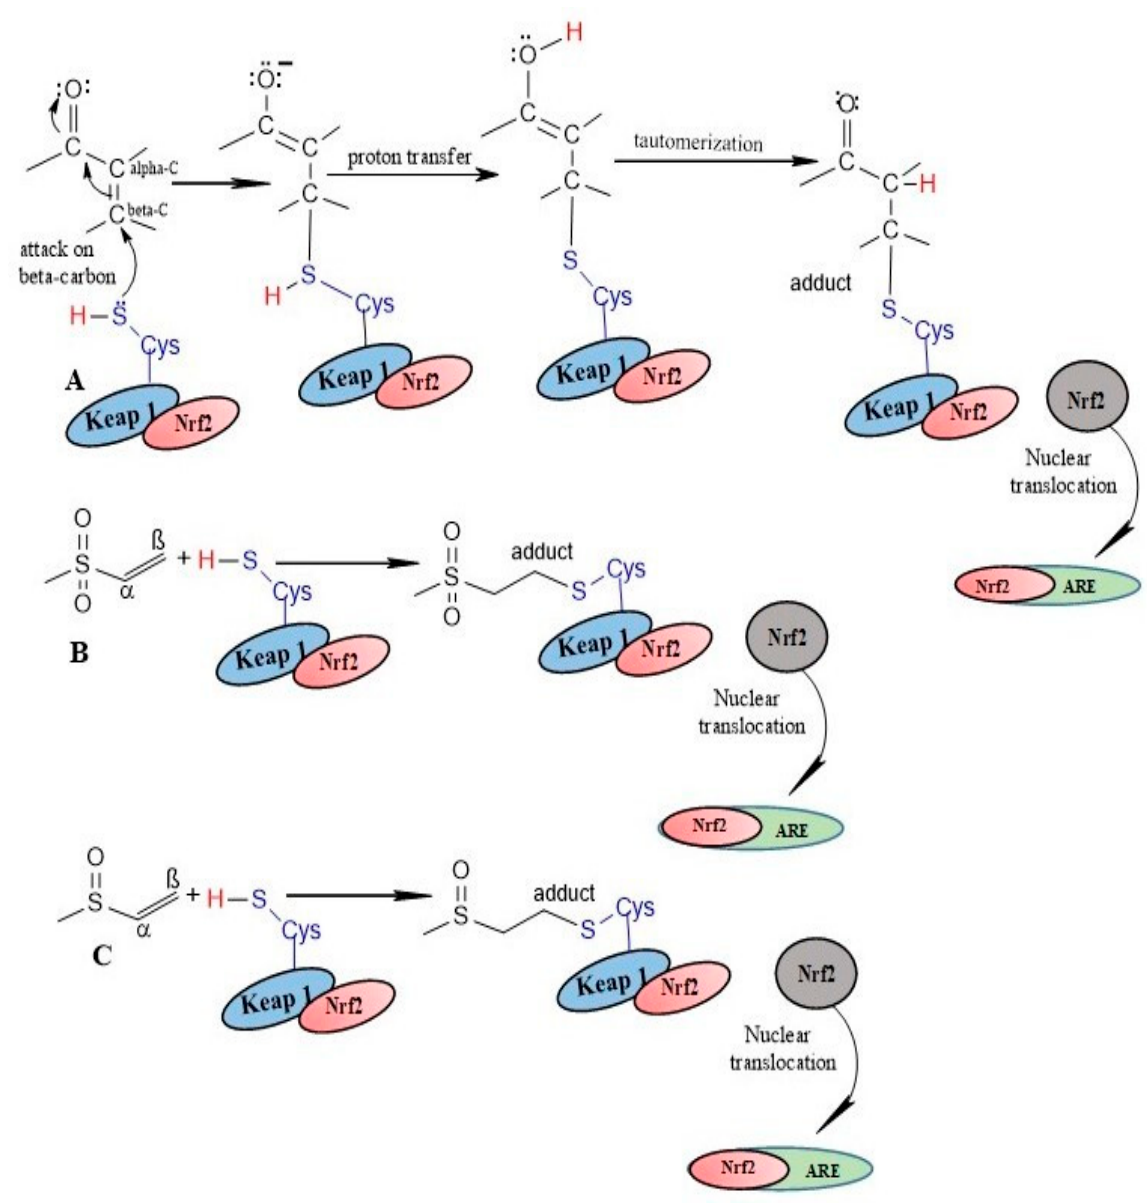
Scheme 3. Reaction mechanisms of α , β -unsaturated ( A ) carbonyl, ( B ) sulfonyl and ( C ) sulfinyl moi- eties. The nucleophilic attack of the thiol of the KEAP1 cysteine residues on the β carbon of